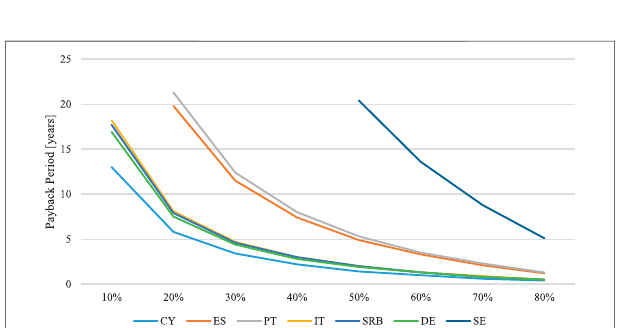
FIGURE 11 | CO 2 payback period per country for the double U-tube GSHP system (compared to ASHP), with various drops in ASHP ef fi ciency (COP), for the GWP impact per